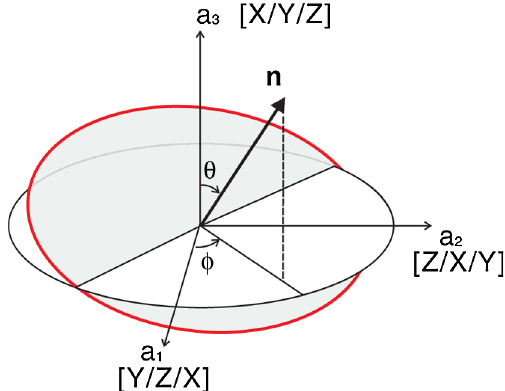
FIG. 14. (Color) Coordinate system for defining the orientation error of a Hall probe. The white circle with black outline shows a Hall probe with no orientation error and ð a 1 ; a 2 ; a 3 Þ is the coordinate system attached to it, which may be related to the coordinate system for the wiggler ð X; Y; Z Þ . The gray circle with the red outline shows a Hall probe with an orientation error defined by the azimuthal angle (cid:1) and the polar angle (cid:7) . The vector n is a unit vector normal to the Hall probe with the orientation